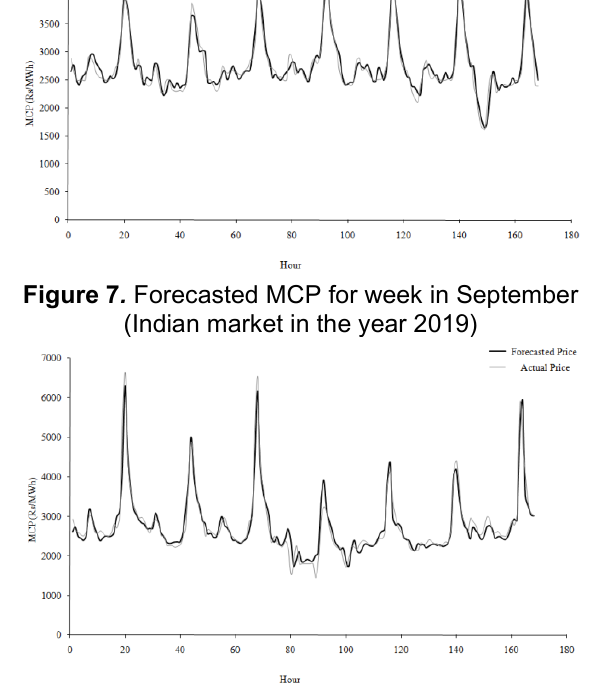
Figure 8 . Forecasted MCP for first week in